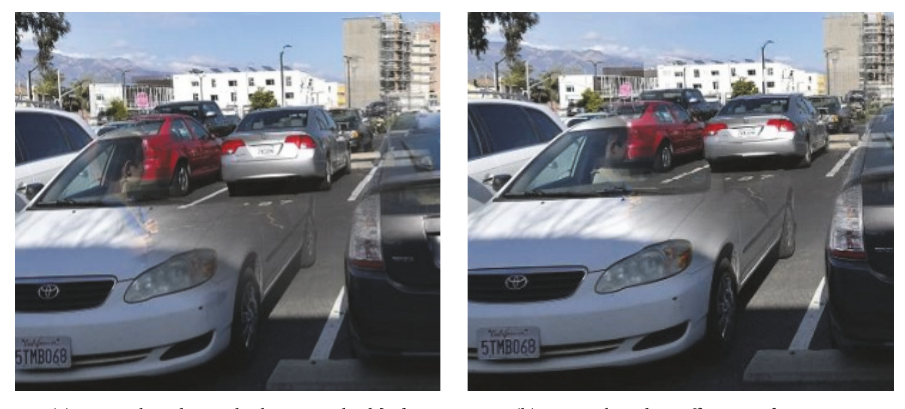
Figure 10: The results of two projection methods.